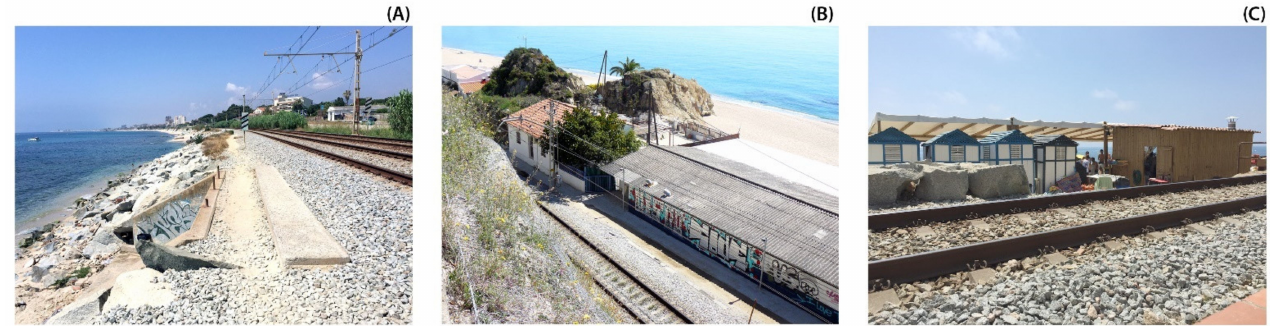
Figure 3. Fieldwork views of the Maresme littoral (Source: authors’ own). ( A ) Canalized stream mouth below the railway. ( B ) Factory located between the railway and beach. ( C ) Beach bar and facilities close to the